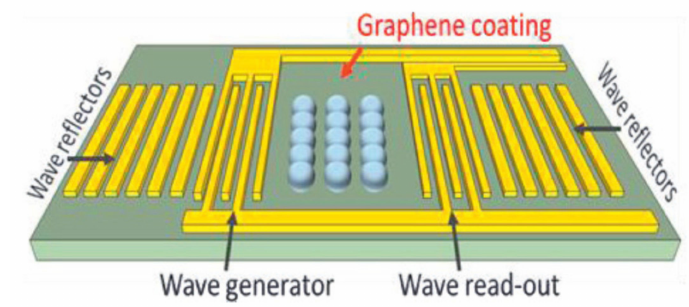
Figure 7. The designed two-port SAW sensor in a dual configuration. Reprinted with permission from Ref. [33]. Copyright 2014